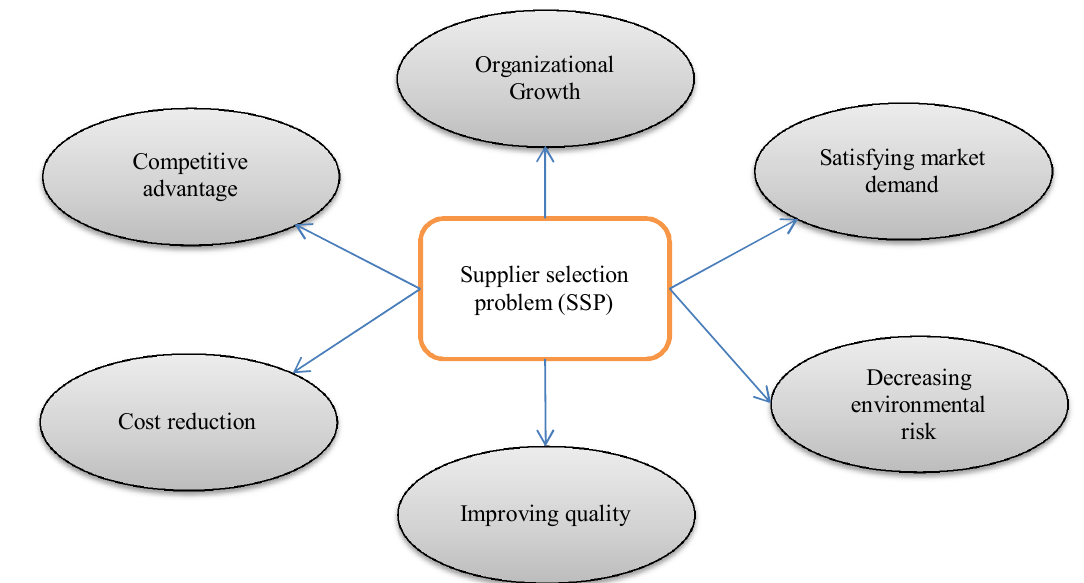
Fig. 1. Supplier selection problem and its general